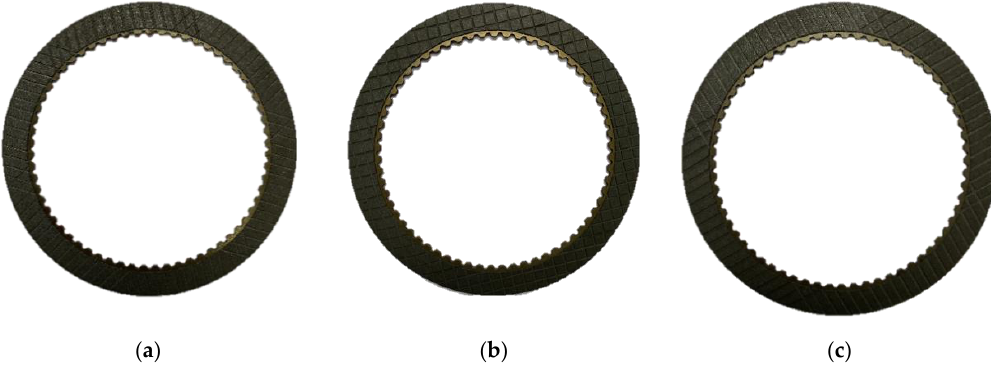
Figure 11. Three kinds of friction disk: ( a ) three-way parallel groove friction disk; ( b ) waffle groove friction disk; and ( c ) two-way parallel groove friction disk.